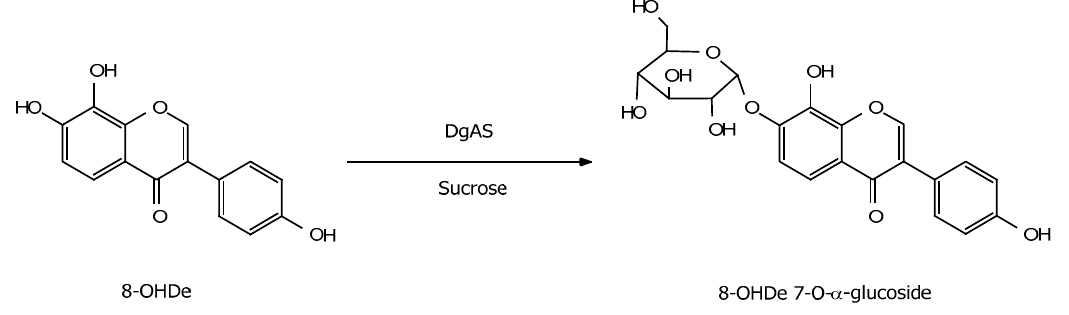
Figure 4. Biotransformation process of 8-OHDe by DgAS.